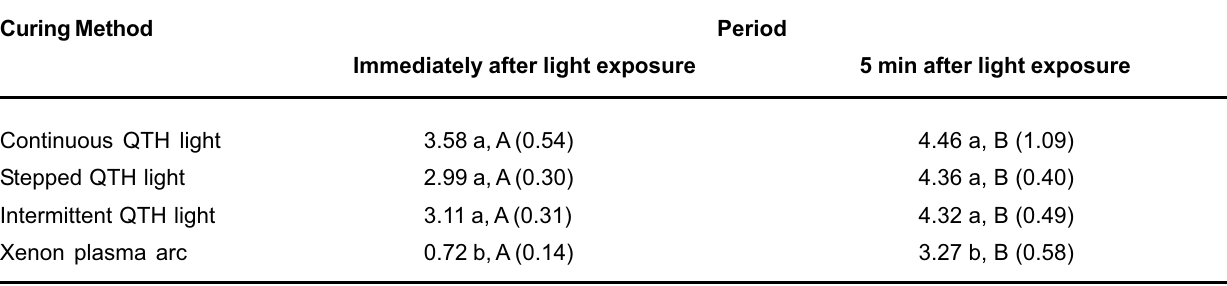
Different lowercase letters in columns and uppercase letters in rows indicate statistically significant difference (Tukey’s test;